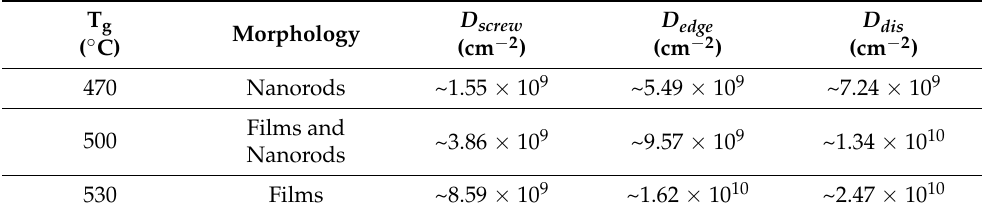
Table 1. The dislocation density of all InN